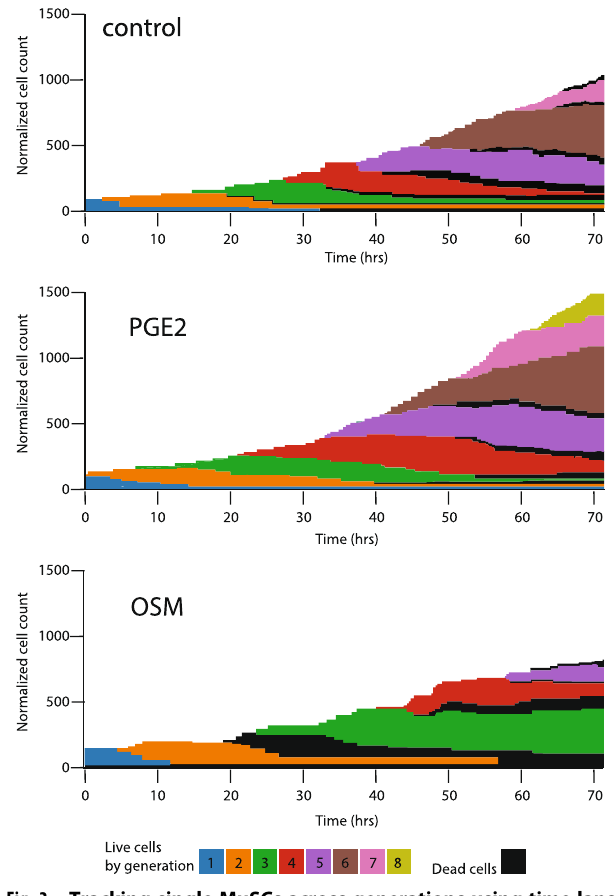
Fig. 3 Tracking single MuSCs across generations using time lapse imaging. The Dual-FLIT approach enables tracking of individual MuSCs and their progeny through numerous rounds of cell division as shown in color-code by generation. Dead cells each in each condition are shown in black. Treatment with PGE2 accelerates cell division, with some microwells having progeny in the 8th generation after 3 days. In contrast, OSM slows down proliferation, acting as a pro-quiescence factor. At least 18 independent clones were tracked for each condition from at least 2 independent experimental